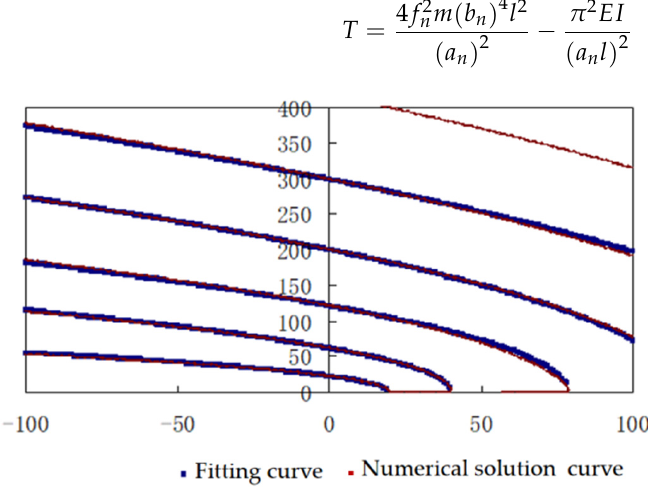
Figure 6. Equation (11) is numerically fitted to the theoretical equation.